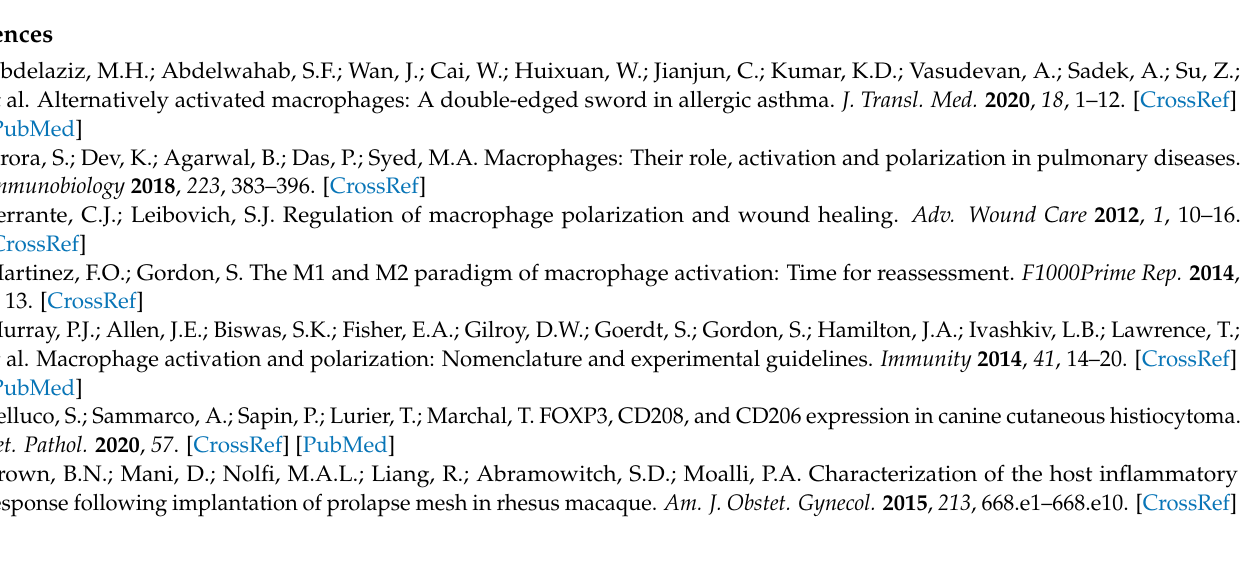
CD 68 protein sequences. Figure S2. Homology sequence analysis of pig and human CD206 proteins. Figure S3. Quantitative analysis of the CD 206 expressing cells, based on random examination of 3 sets of 1000 cells per condition. Figure S4. Expression of CD206 mRNA in the non-treated muscle by in situ DIG hybridization. Table S1. Oligos used for in situ hybridization